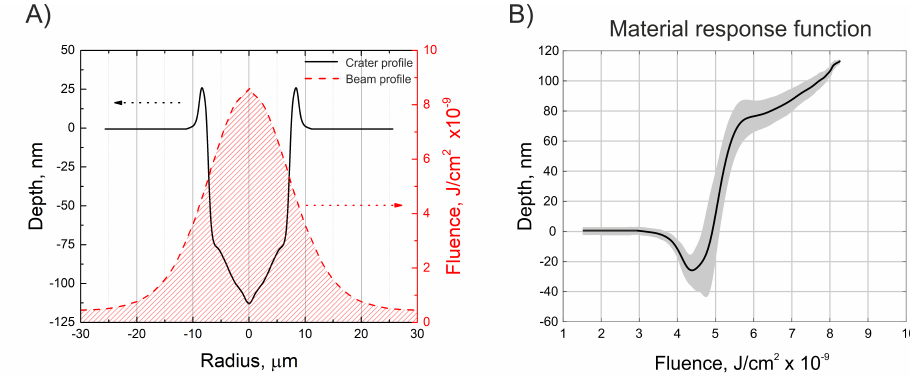
Figure 4. Fluence profile of the laser beam at its focus position, measured and rescaled to its actual size, and the measured geometry of the crater produced with a such laser beam ( A ). Constructed material response function, which shows how much material is removed at precise fluence value ( B ). The black line represents the average value, whereas the grey area shows the boundaries of standard deviation. The laser source used was number 3 (see Table